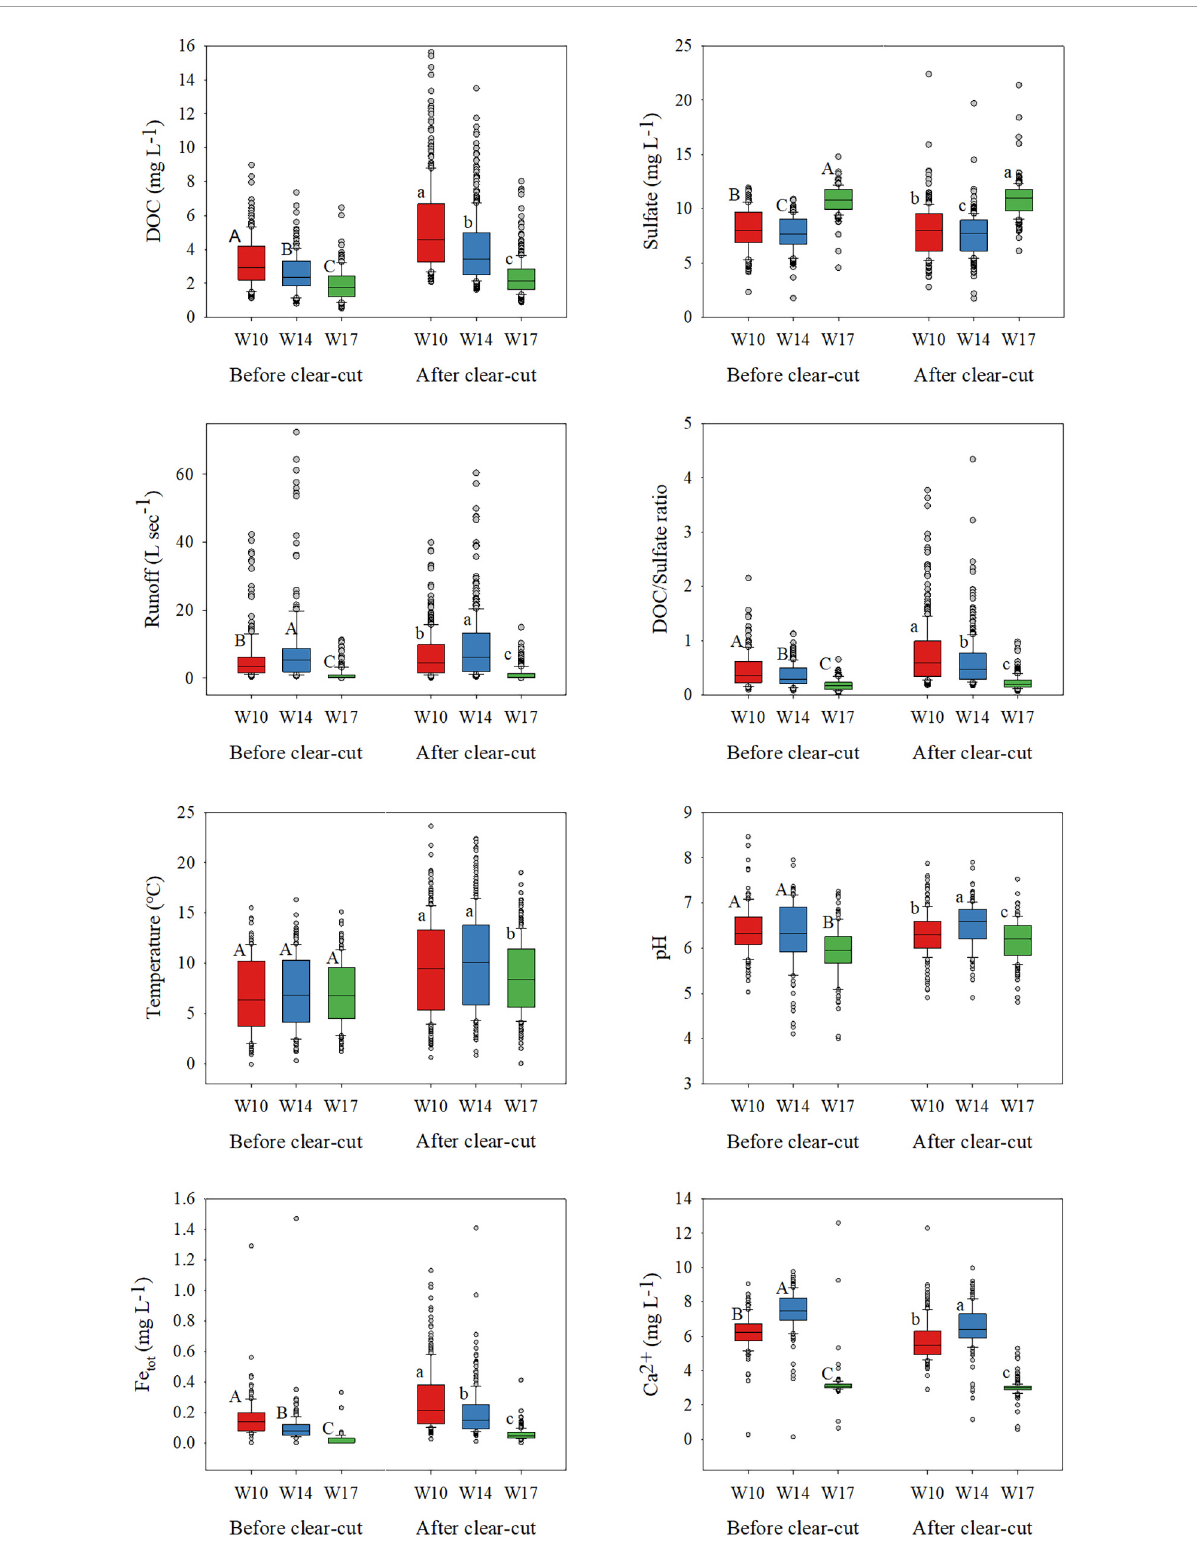
FIGURE4 Boxplots before and after clear-cut of different variables at the three Wüstebach catchment stations (W10, W14, W17). DOC: dissolved organic carbon, DOC/Sulfate ratio: DOC to sulfate ratio, Fe tot : Total dissolved iron. Different upper and lower letters indicate significant differences among 3 stations before and after the clear-cut,